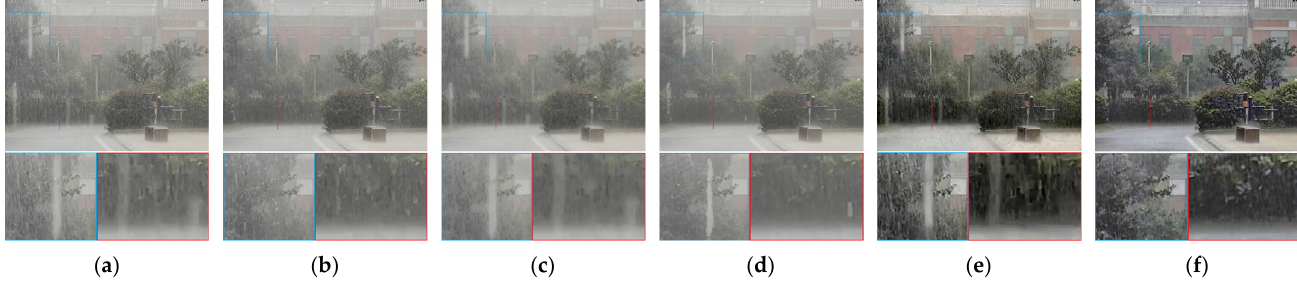
Figure 12. Comparison on a real rain video. ( a ) Input, ( b ) Kim et al. [16], ( c ) Wang et al. [8], ( d ) Li et al. [14], ( e ) Chen et al. [32], ( f ) proposed method.